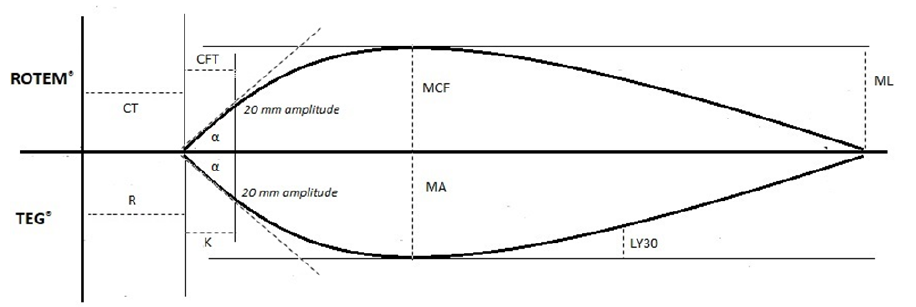
Figure 2. Illustration of thromboelastography (TEG ® ) tracing and the accompanying parameters. Abbreviations: R: reaction time; K: kinetics time; α: alpha angle; MA: maximum amplitude; LY30: lysis at 30 min.